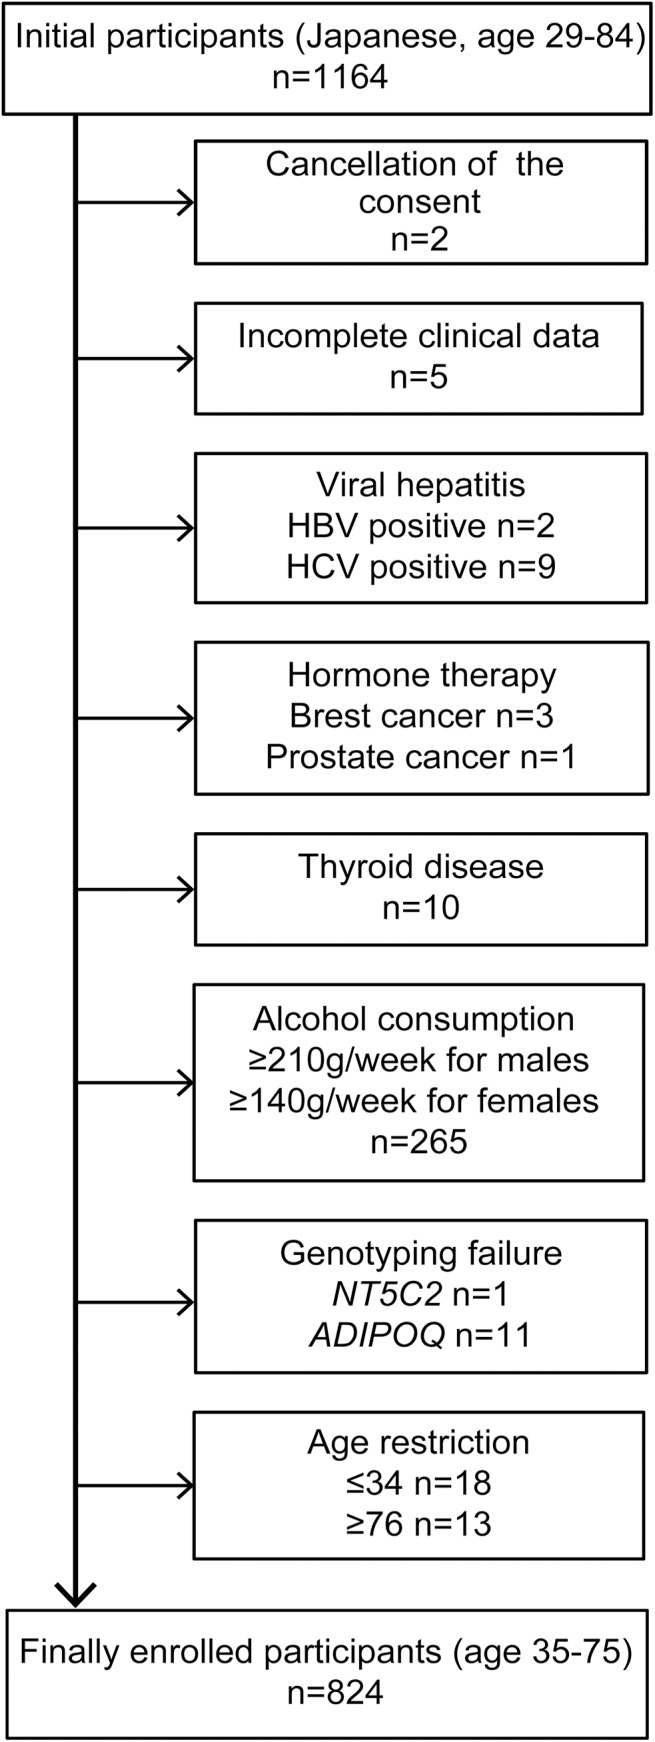
Flowchart of the inclusion and exclusion criteria.HBV, hepatitis B virus; HCV, hepatitis C virus; NT5C2, 5’-nucleotidase, cytosolic II; ADIPOQ, adiponectin.